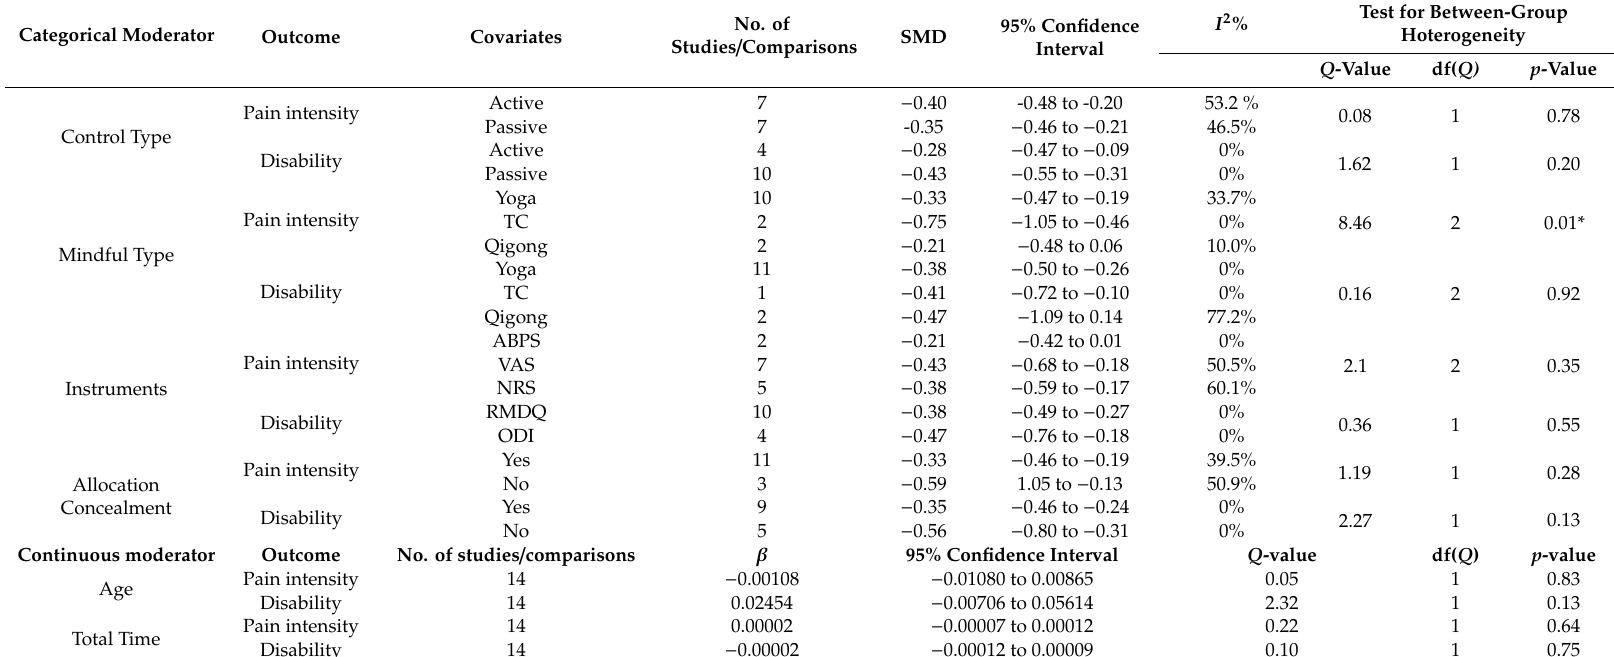
Table 3. The e ff ect of mind-body exercise in moderator